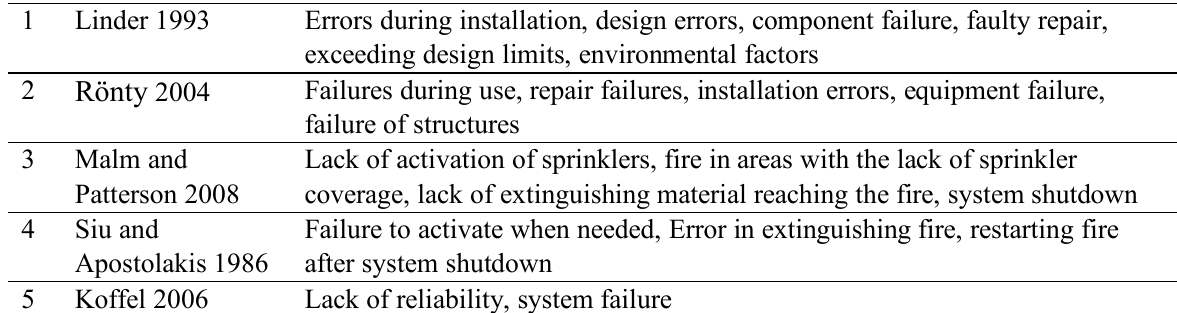
Table 1. Causes of failure in studies